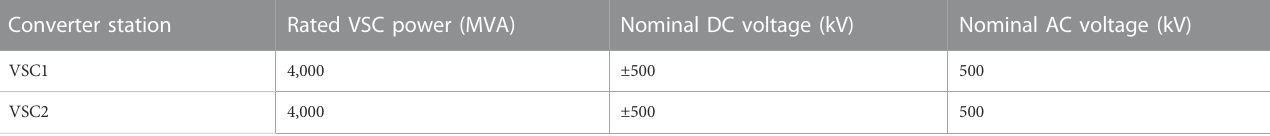
TABLE 2 Converters ’ parameters in the VSC-HVDC system.